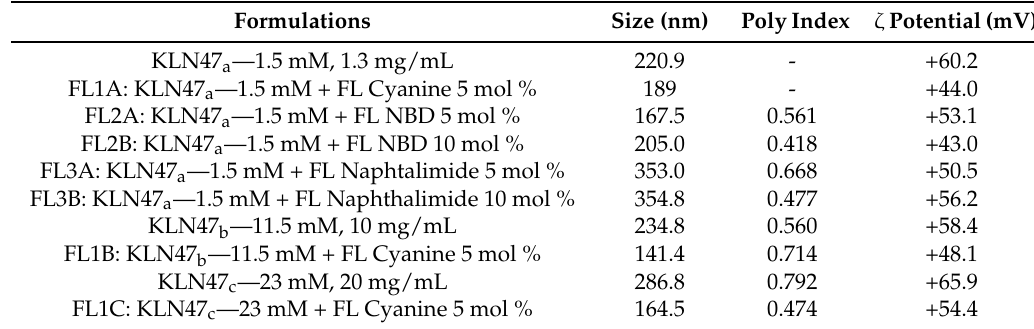
Table 1. Chemical characteristics of fluorescent cationic lipids.